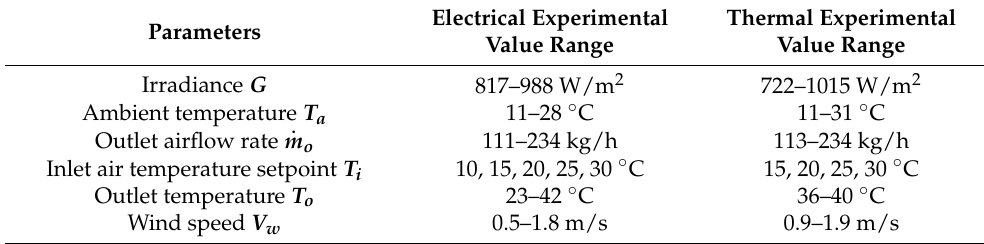
Table 7. Range of the different measurements during the outdoor steady-state